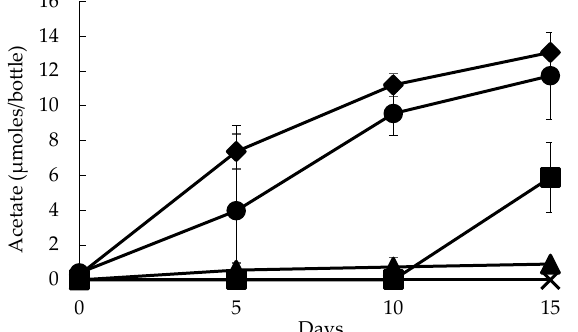
Figure 2. Autotrophic reductive acetogenesis by humin-dependent consortium PCPA0. The data are plotted for the self-sacrificing triplicates used for the batch culture for the timeline period of 0, 5, 10, and 15 days, except for PCPA0 where duplicates were studied. PCPA0 represents the 11th generation of consortium PCPA0 in Med-A, that is, conditioned to CO 2 / HCO 3 − in medium, and headspace is flushed with N 2 / CO 2 ; and humin 1g as well as 0.20 mM of reducing agent (Ti-NTA) was added to the medium ( • ). PCPA0-C1 had microbial source without humin in Med-A under HCO 3 − / CO 2 condition ( (cid:78) ) with N 2 / CO 2 in headspace. PCPA0-C2 used both humin and microbial source in Med-A, that is, under HCO 3 − / CO 2 condition, but reducing agent was not added ( (cid:7) ). PCPA0-C3 used both bacteria and humin, but CO 2 / HCO 3 − was substituted with MOPS in Med-A, and headspace was flushed with N 2 only ( (cid:4) ); Control-1 used only humin in Med-A ( × ) under N 2 / CO 2 atmosphere without bacteria. The acetate values represent the mean with standard deviation shown by vertical